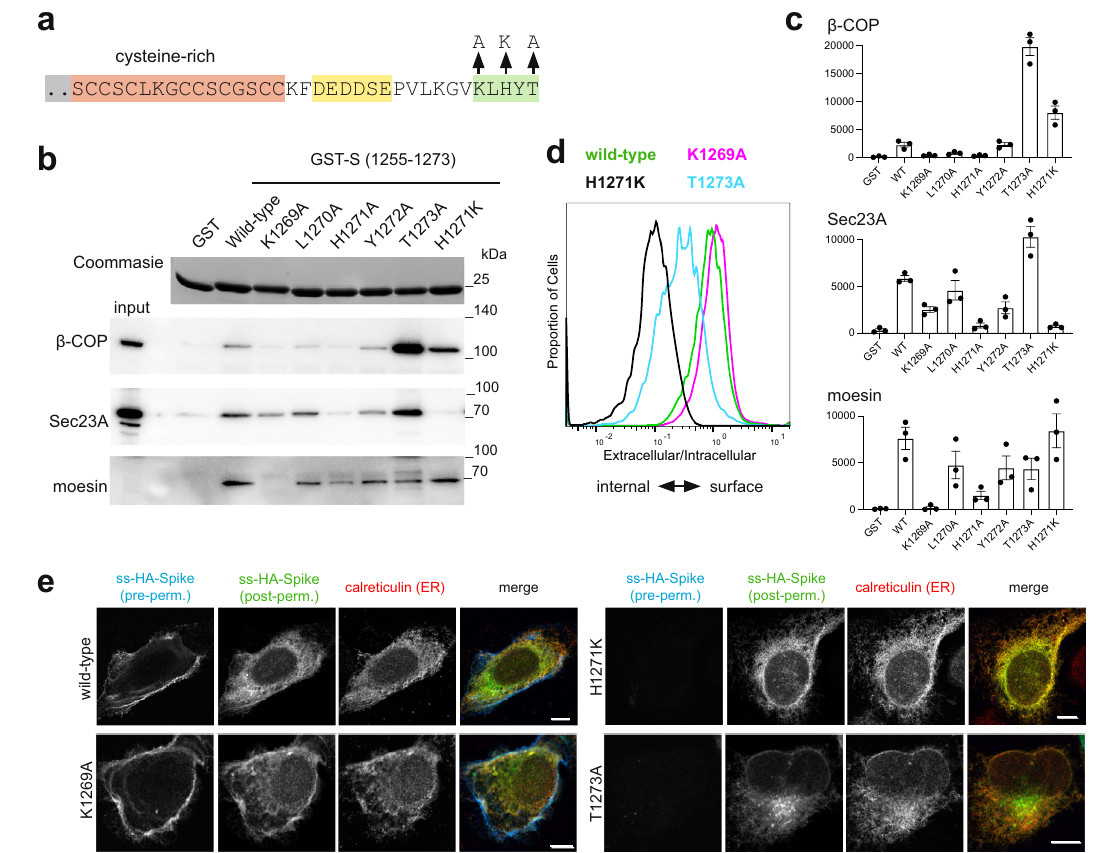
Fig. 4 The cytoplasmic tail of the SARS-CoV-2 S protein has a suboptimal ER retrieval motif. a Schematic of the cytoplasmic tail of S protein showing three different mutations made in the COPI-binding site. b Beads coated with the indicated recombinant S tail GST-fusions were incubated with clari fi ed lysate from 293T cells and the eluates immunoblotted for β -COP (COPI), Sec23A (COPII) and moesin. Representative blots from three independent experiments, input 1/50 of that applied to beads. c Quanti fi cation of the blots in (b), data from the three independent experiments (arbitrary units), showing mean values and SEMs. d Flow cytometry analysis of U2OS cells expressing the indicated forms of S. The histograms represent the ratio of extracellular S (AF488 signal) to that of intracellular S (AF647 signal). Histograms normalised to the mode value and represent ~10,000 events. Chi- squared tests show the differences between the median ratios of the wild-type (0.87) and those of K1269A (1.1), H1271K (0.11), and T1273A (0.12) to all be statistically signi fi cant ( P = 0.01, 99% con fi dence). Representative of four independent experiments. e Micrographs of U2OS cells transiently expressing N-terminally HA-tagged wild-type S or the indicated mutants. Cell surface S was initially stained using AF647-labelled anti-HA under non-permeabilising conditions. Cells were then permeabilised and stained with AF488-labelled anti-HA to detect the internal S, and for the ER marker calreticulin. Both H1271K and T1273A accumulate in the ER, with the latter ’ s additional perinuclear location presumably re fl ecting subtle differences in relative ER-to-Golgi, and Golgi-to-ER transport kinetics due to differential effects on COPI and COPII binding. Scale bars 10 μ m, with the images for the individual channels taken at the same magni fi cation as the merged image that has the scale bar. The experiment was repeated